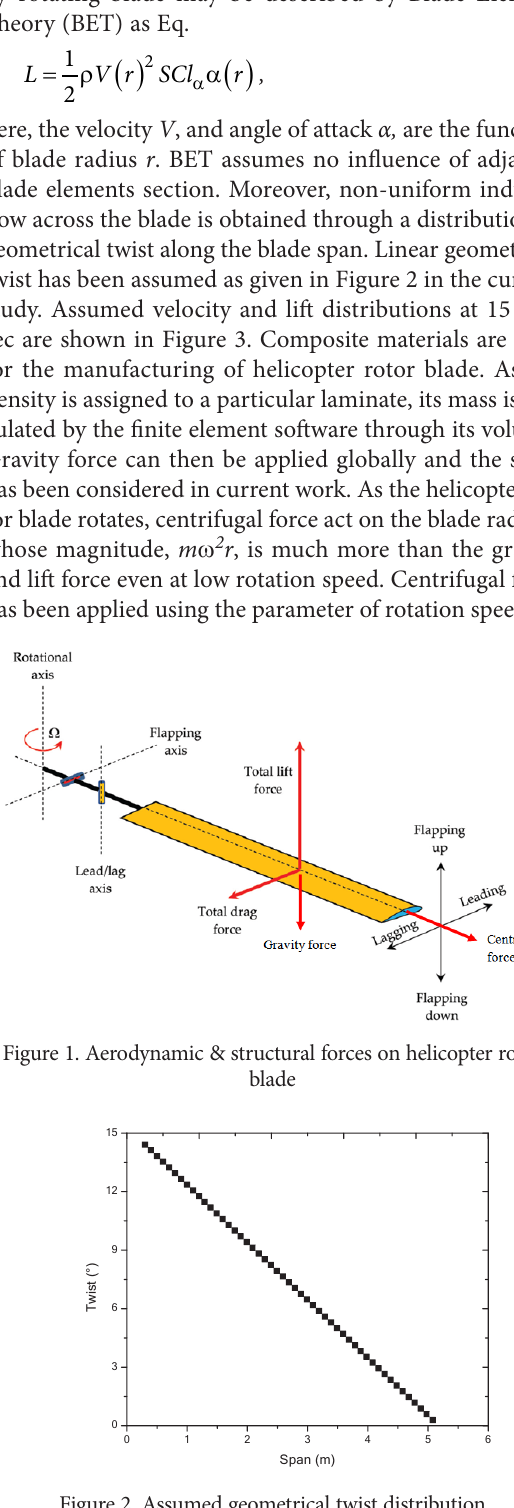
Figure 1. The lifting force on a rotating blade is related to its local angle of attack and local dynamic pressure. There the rotational axis and the maximum at the tip. Moreo- ver, geometrical twist angle increases from tip to root.